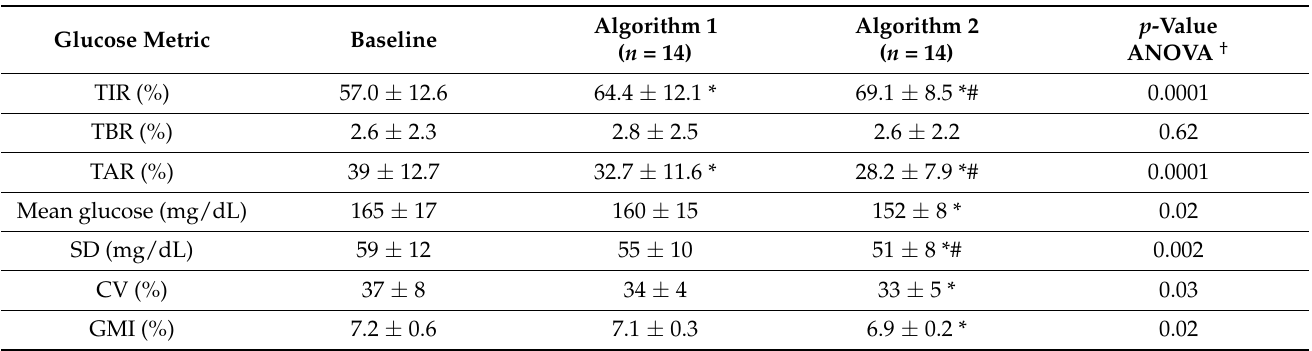
Table 5. Comparison of glucose metrics collected at baseline and after Algorithm 1 (DirectNet/JDRF) and Algorithm 2 (Ziegler) in patients treated with CSII